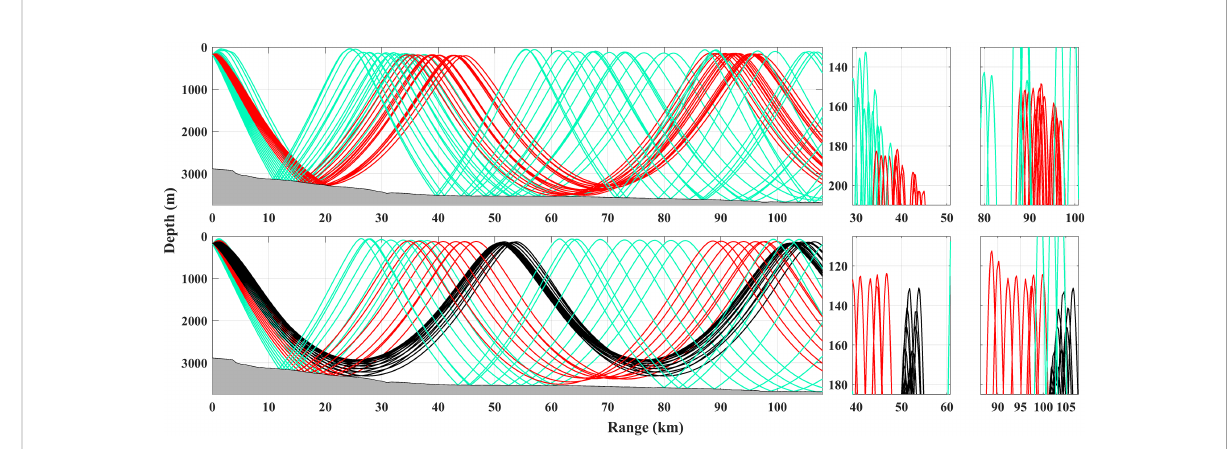
FIGURE 7 The comparison of simulated sound ray traces with 300 Hz frequency between the warm eddy (upper panel) and none eddy (lower panel) circumstances. The two right columns show the enlarged and detailed